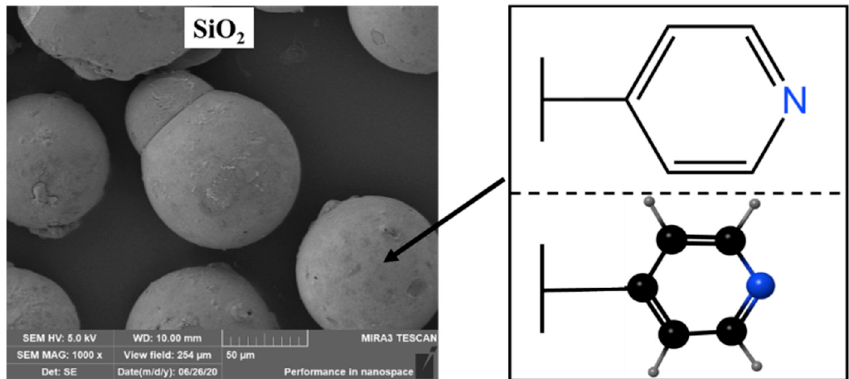
Figure 1. Schematic representation of the N3/SiO 2